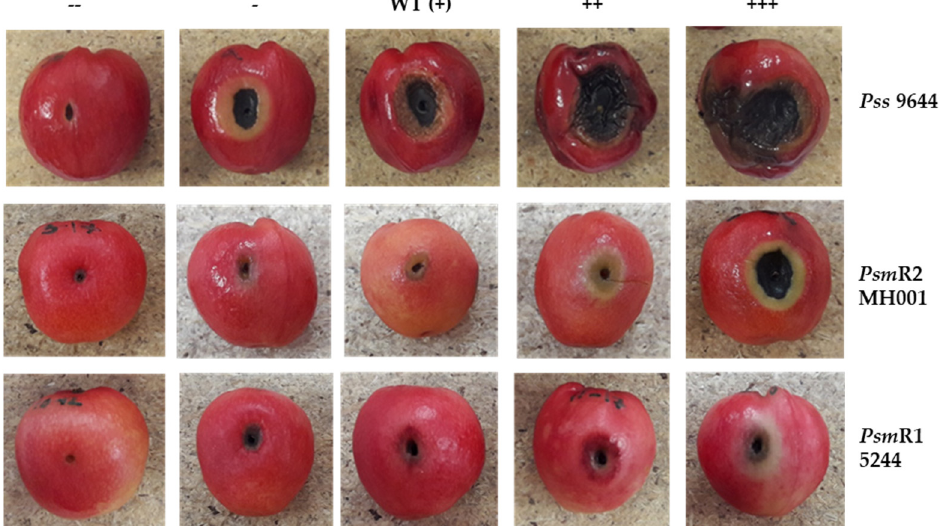
Figure 1. Screening of Pseudomonas transposon disruption mutants for changes in pathogenicity on cherry fruit. Transposon mutants and associated wild-type (WT) strains were inoculated into immature cherry fruit and photographed after 5 days. Symptoms were scored as WT (+), as displayed by the wild-type strain; --, no symptoms; -, reduced symptoms; ++, increased symptoms; +++, increased symptoms with clear signs of spread. Psm , P. syringae pv. morsprunorum ; Pss , P. syringae pv. syringae .